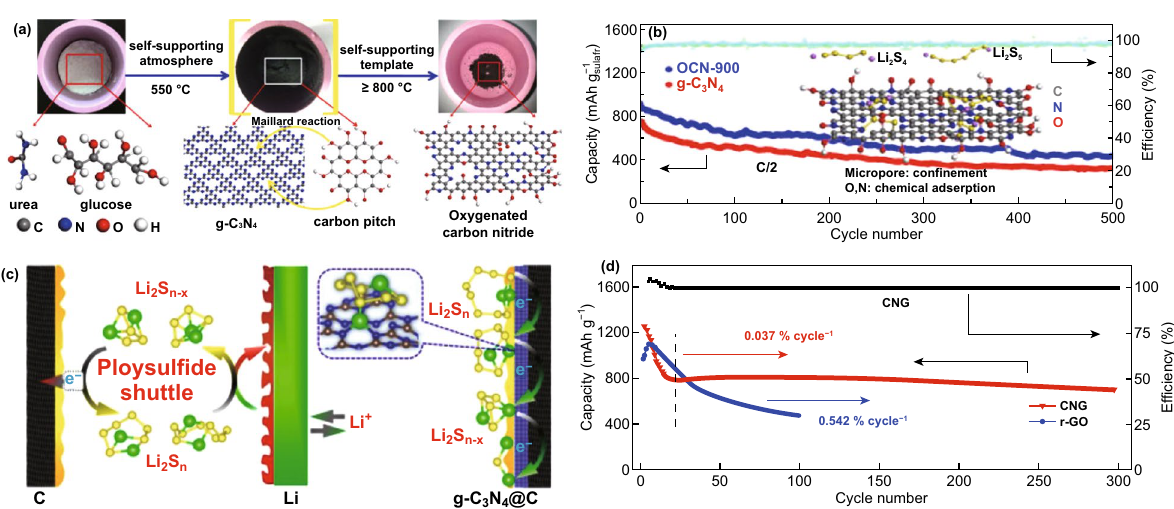
Fig. 22 a Schematic illustration of graphene-like oxygenated carbon nitride (OCN) prepared by one-step self-supporting solid-state pyrolysis. b Cycling performances of the OCN sample prepared at different conditions and g-C 3 N 4 at C/2 after initial activation process to allow complete access of the electrolyte to the active material. Inset: OCN with adsorbed LiPSs molecules. Reproduced with permission from Ref. [136]. c Schematic of the mechanism for polysulfide adsorption by the g-C 3 N 4 @CFM cathode. Reproduced with permission from Ref. [67]. d Cycling performance of LiPSs on CNG and r-GO. Reproduced with permission from Ref. [57]. Copyright permissions from American Chemical Society and Wiley–VCH. (Color figure